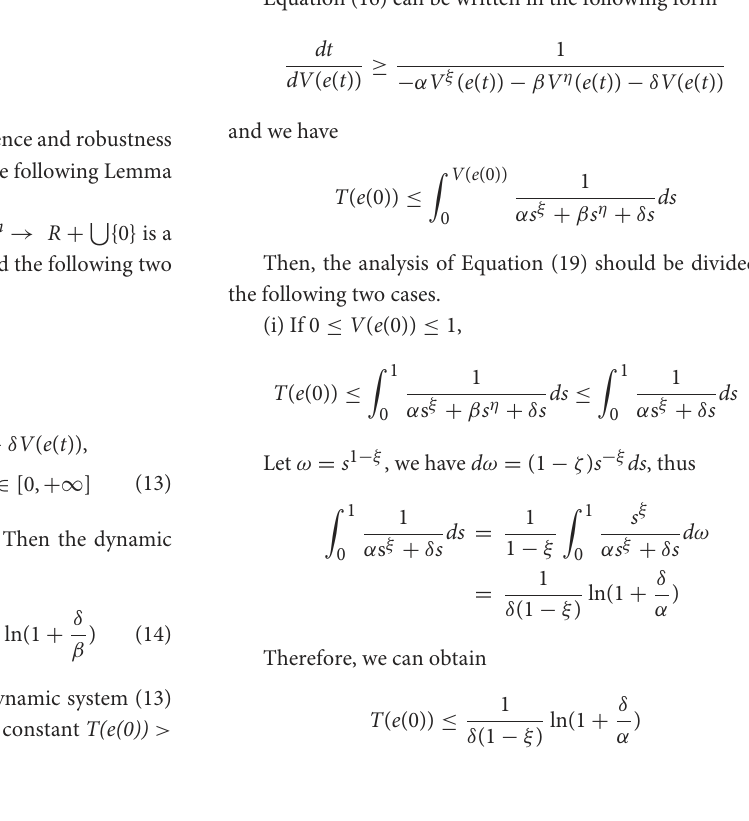
Each orange circle represents a time-varying matrix or their derivative matrix, and the number of neurons in each orange circle depends on the number of matrix elements. Besides, the convergence factor γ is set as 1 for fair